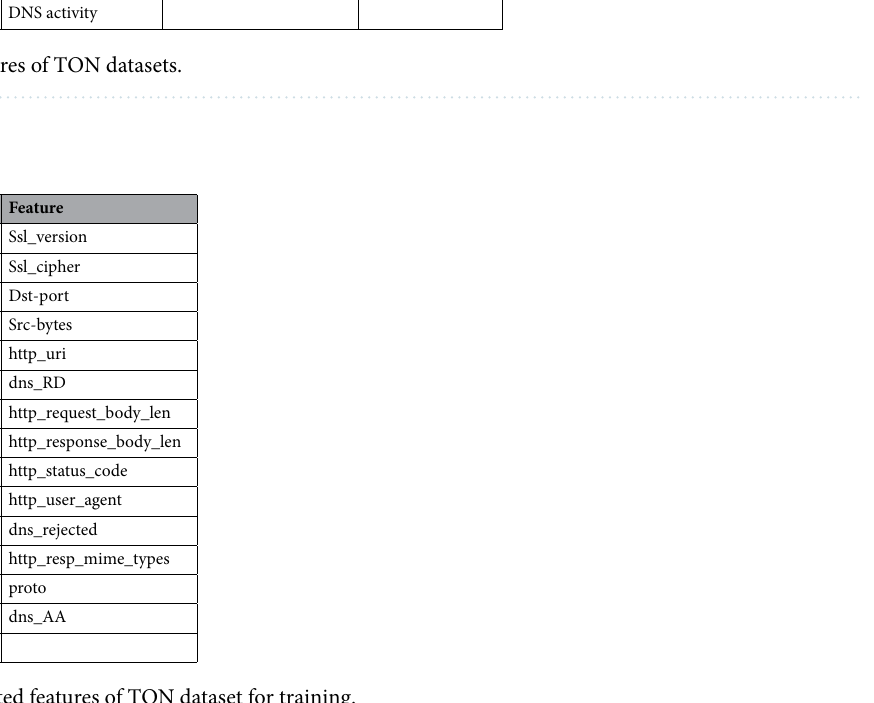
Table 3. Selected features of TON dataset for